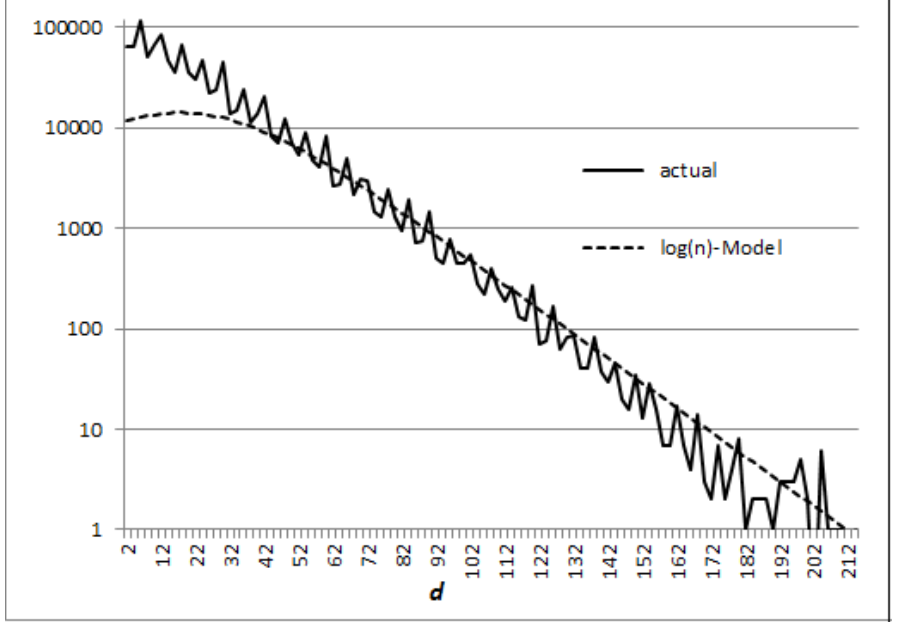
Figure 1. Numbers of successive prime pairs as function of the gap d = p n + 1 − p n in 49,000,000 ≤ n ≤ 50,000,000 (logarithmic scale).